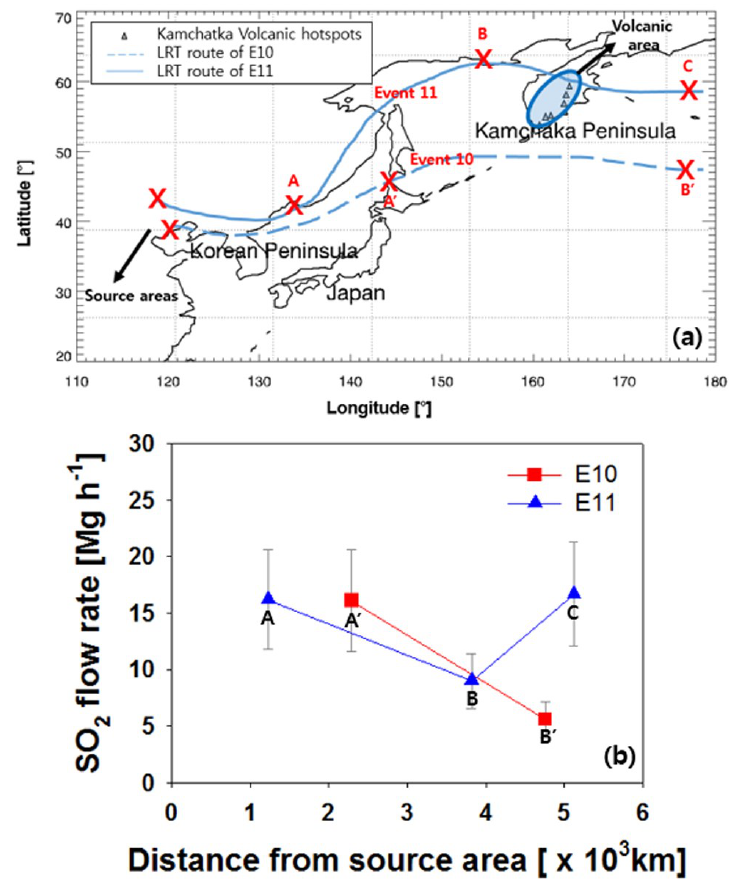
Figure 7. ( a ) air mass pathways for event E10 (dashed line) and E11 (solid line). Open triangles indicate Kamchatka volcanic hotspots. ( b ) SO 2 flow rate as a function of distance from the source areas. A’ and B’ in (a) and (b) correspond to Hokkaido and the Northwest Pacific Ocean (Aleutian Islands), respectively. A, B, and C in (a) and (b) correspond to Vladivostok, Magadan, and the Northwest Pacific Ocean (Bering Sea), respectively.